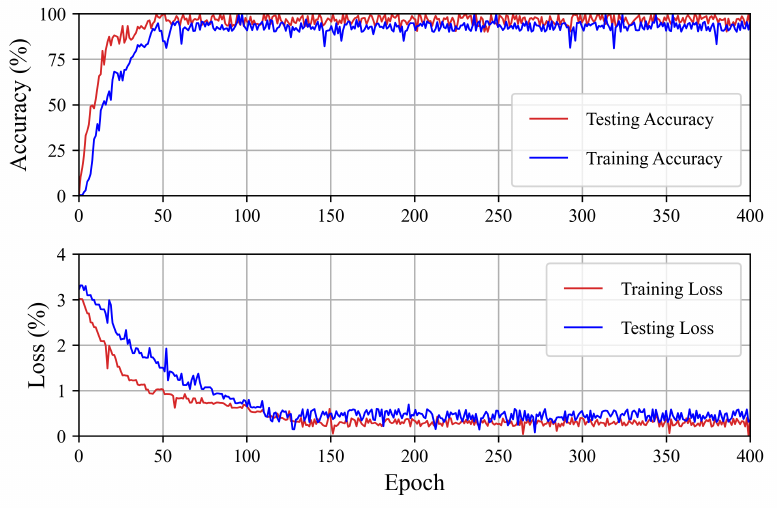
Figure 17. Comparison of accuracy and loss function statistics for training and test